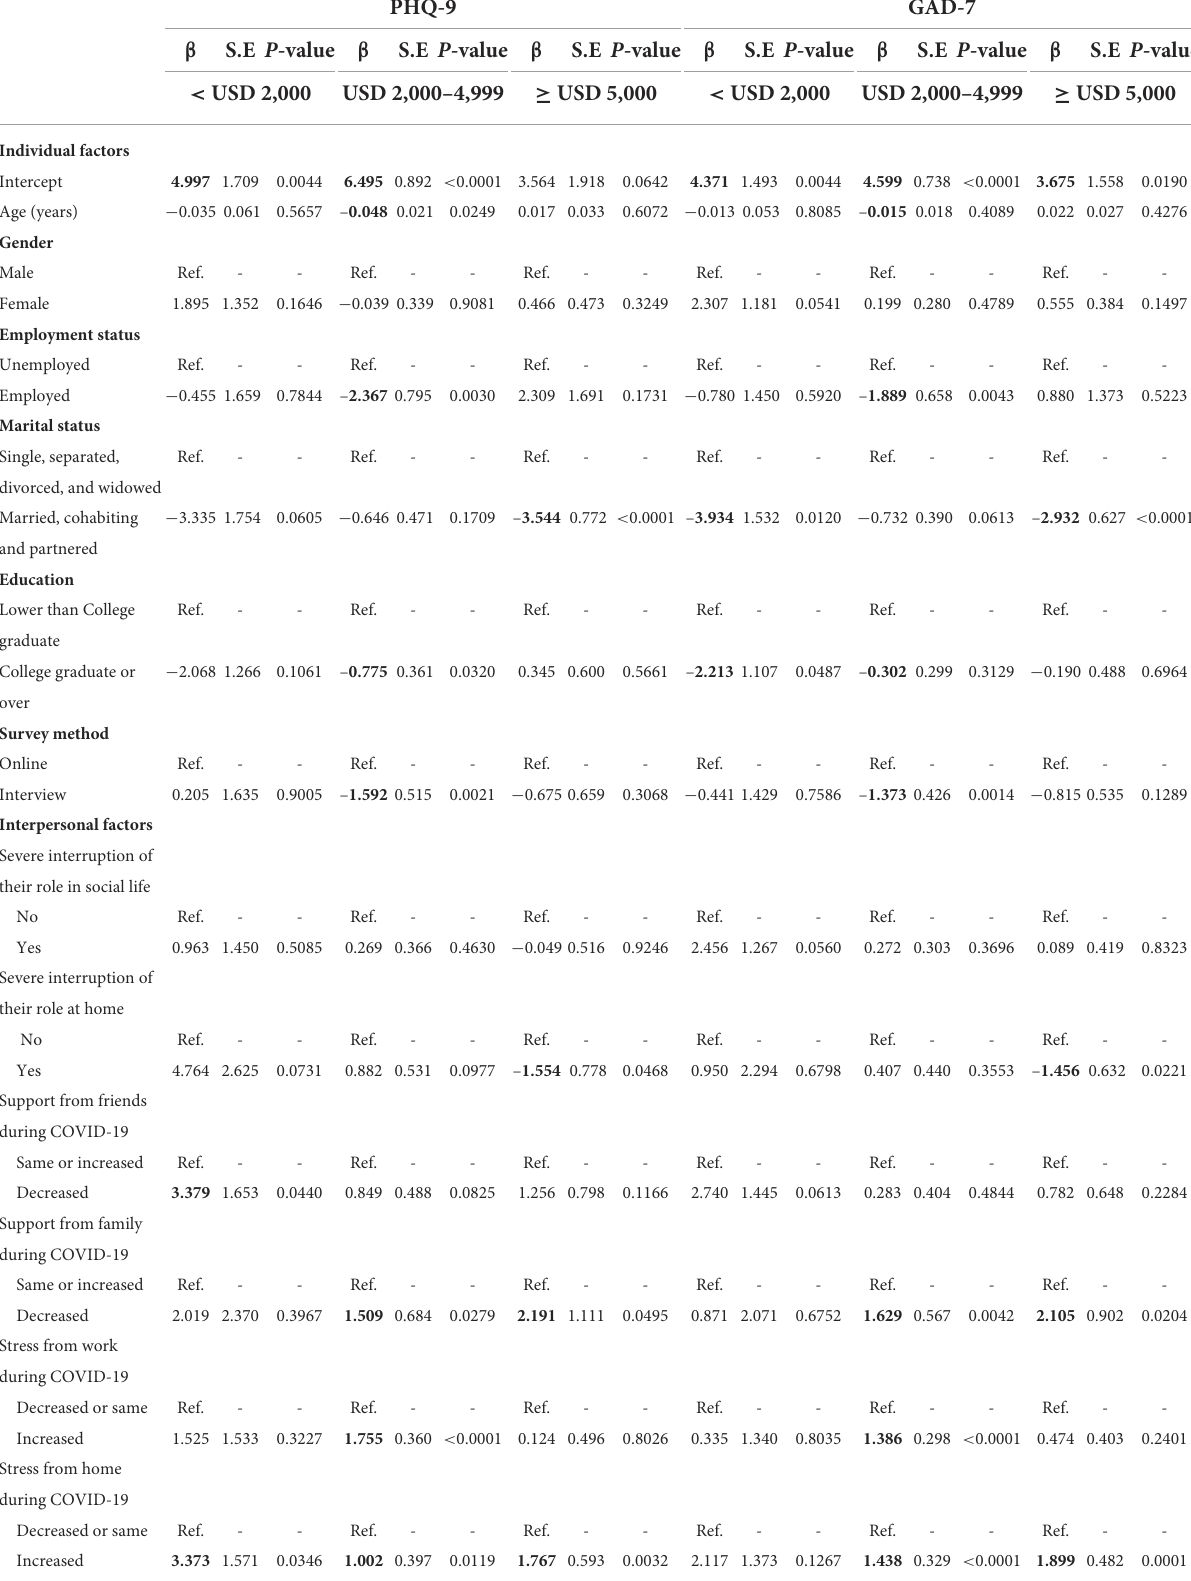
TABLE 5 Subgroup analysis of multiple linear regression for the effect of individual and community factors on mental health status by monthly household